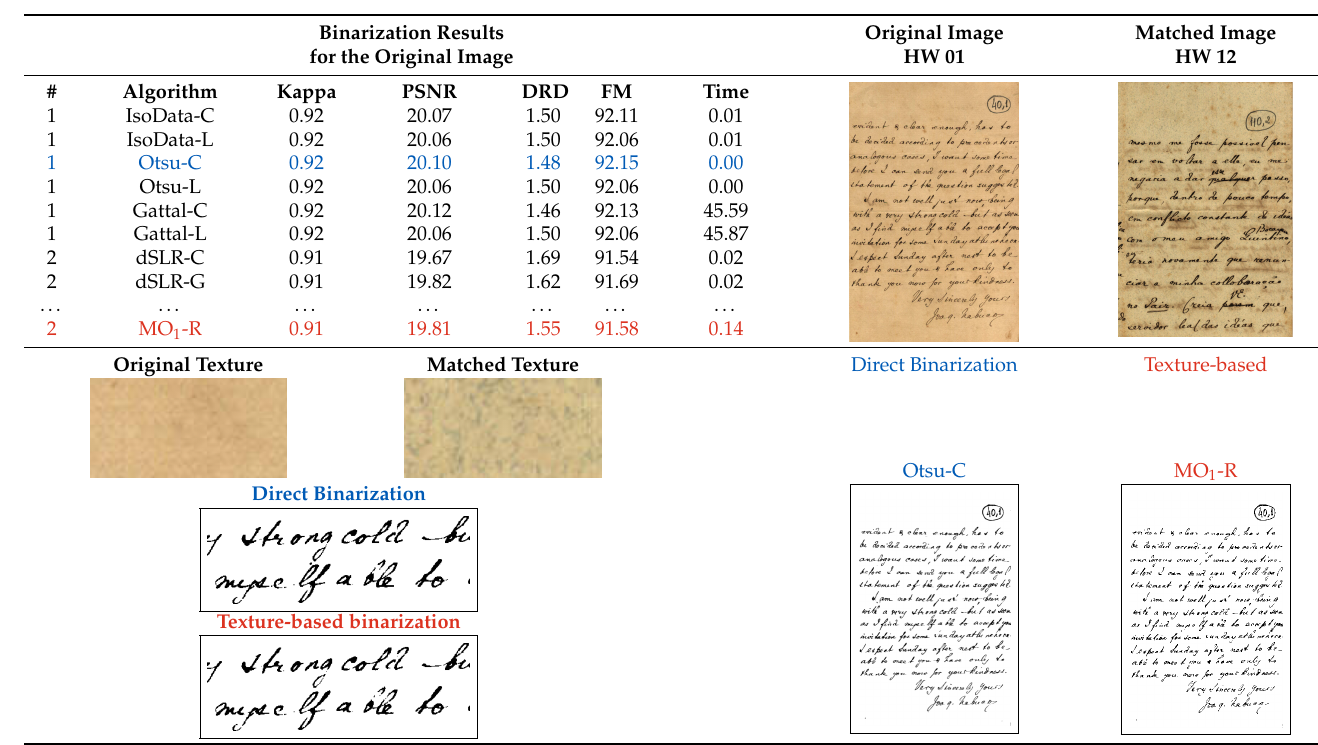
Table 4. Results for image matching with image HW 01.